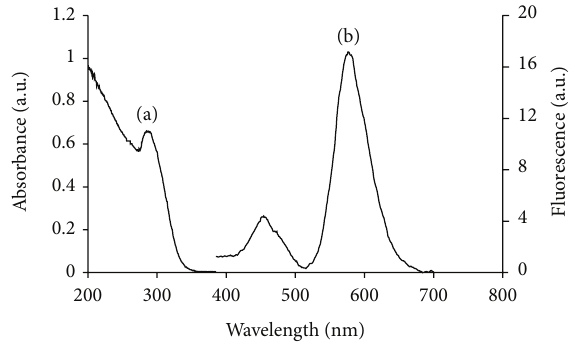
Figure 5: Absorption (a) and fluorescence (b) spectra of L-cysteine- capped Mn-doped ZnS QDs. 𝜆